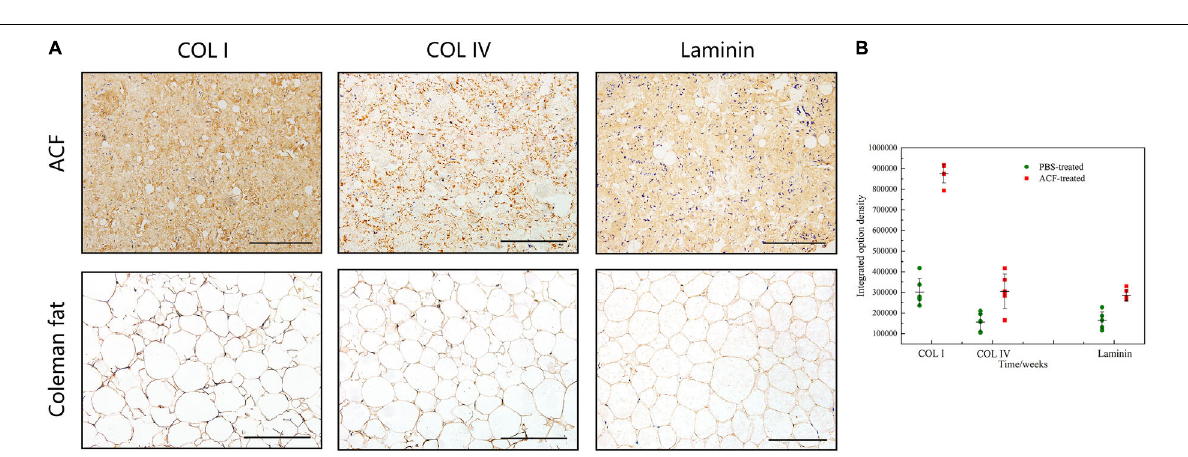
FIGURE 4 | Collagen components assessment of ACF. (A) Immunohistochemical staining of COL I, COL IV, and laminin in ACF. ACF is composed of collagen fragments. COL I, COL IV, and laminin expression in ACF can be detected throughout the entire field of view. (B) Semi-quantitative analysis of collagen I, collagen IV, and laminin in ACF. Scale bar = 100 µ m. P (collagen I) = 7.003E-09, F (collagen I) = 0.407; P (collagen IV) = 0.003, F (collagen IV) = 0.169; P (laminin) = 1.001E-04, F (laminin) =